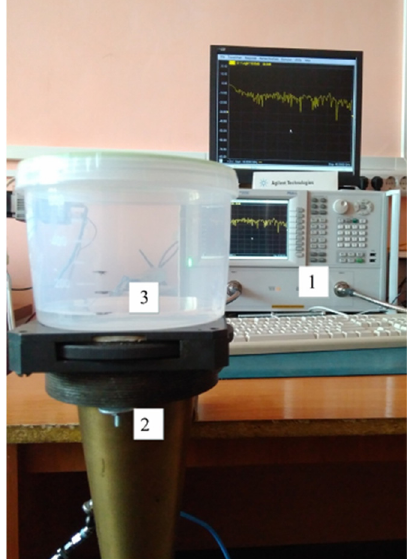
Figure 4. Experimental setup.